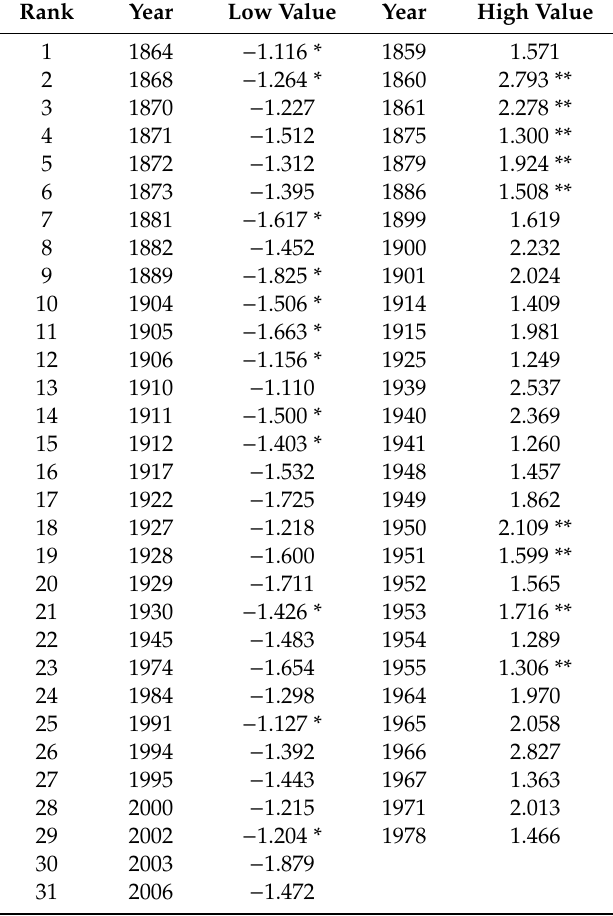
Table 4. Extreme events of reconstructed January–September mean scPDSI for western Liaoning during the period